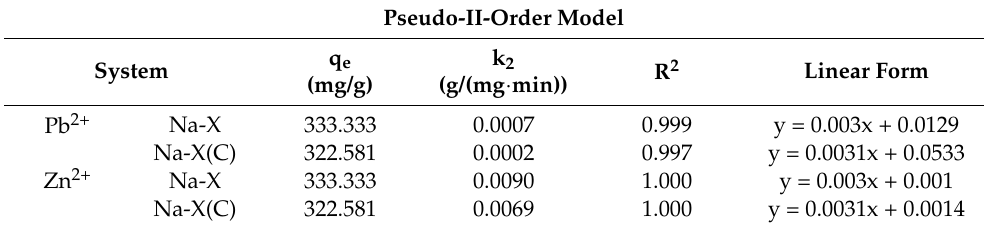
Table 3. Kinetics parameters of Pb 2+ and Zn 2+ adsorption on Na-X and Na-X(C) at pH 5.